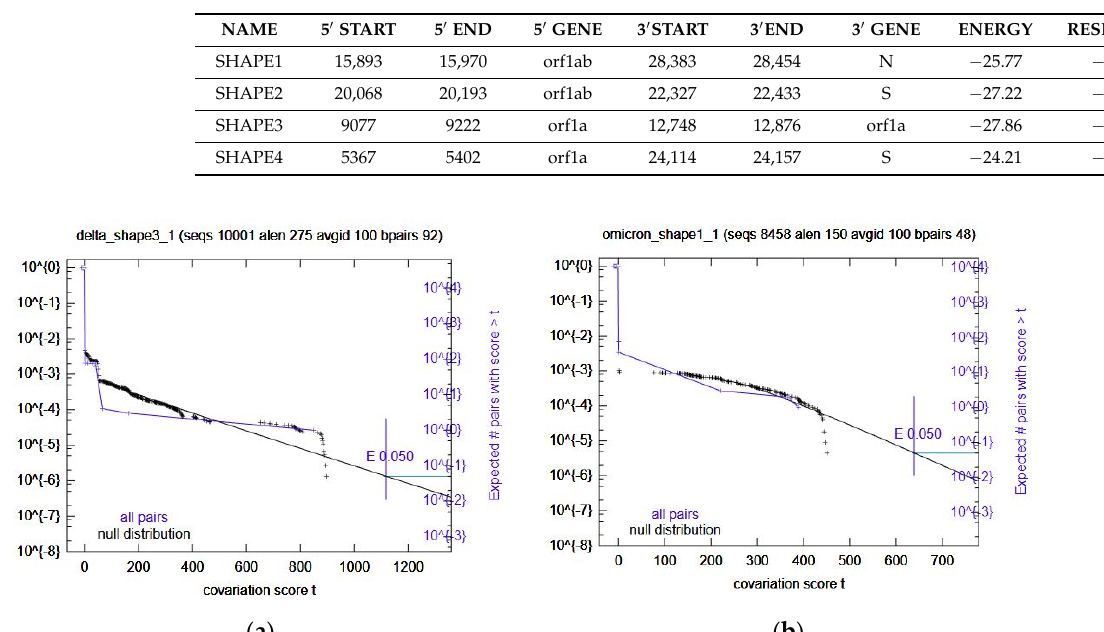
Figure 3. Survival plots from the variant ‐ specific covariation analysis. Displayed are the most sig ‐ nificant results. Omicron Shape1 is shown in panel ( a ) Delta Shape 3 is shown in panel ( b ). Significance cutoff E ‐ value used was 0.05.